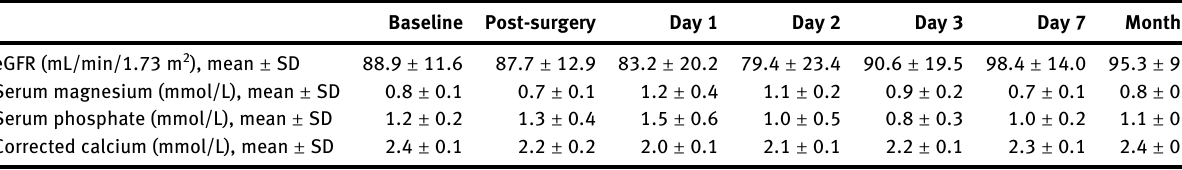
Table  : Further laboratory results (n= 